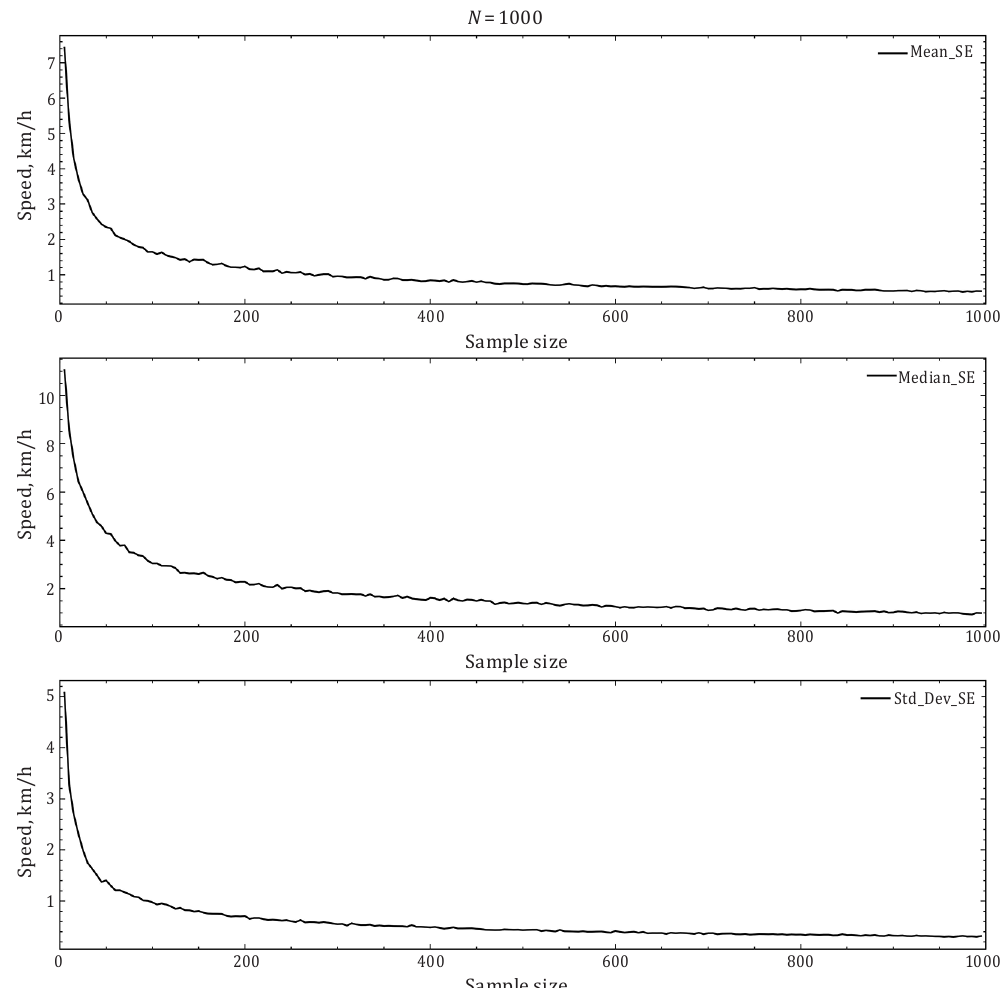
Figure 6. Change of the subsample standard error relative to the